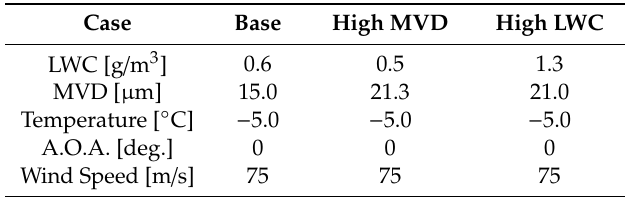
Table 3. Demonstration Test